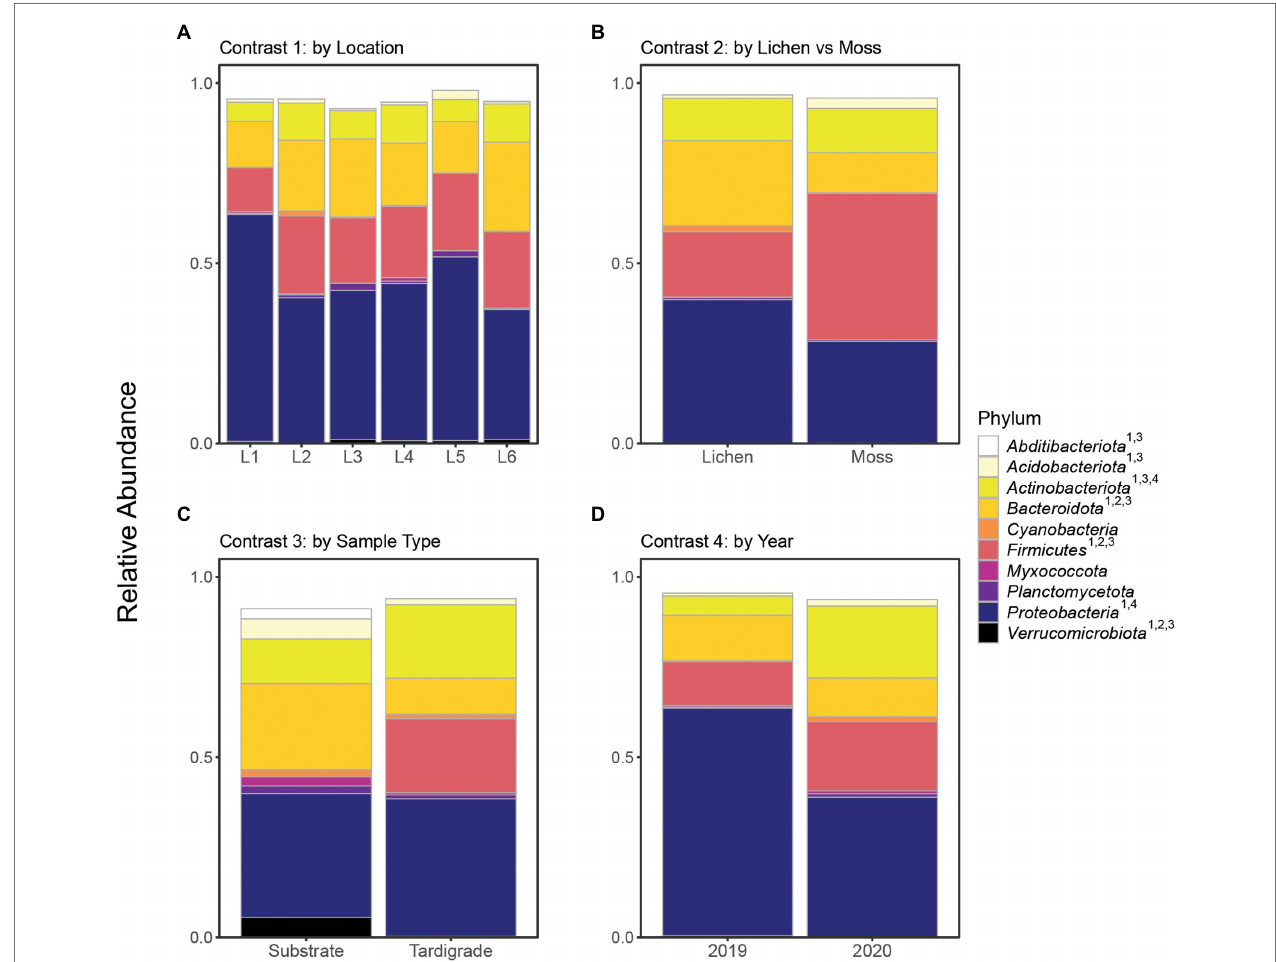
FIGURE 2 | Relative abundance of top 10 identifiable phyla shown across all contrasts. Superscript numbers indicate the contrasts in which a given phylum was significantly differentially abundant. Location names (Location 1 through Location 6) are abbreviated as L1 through L6. (A) Contrast 1, (B) Contrast 2, (C) Contrast 3, and (D) Contrast